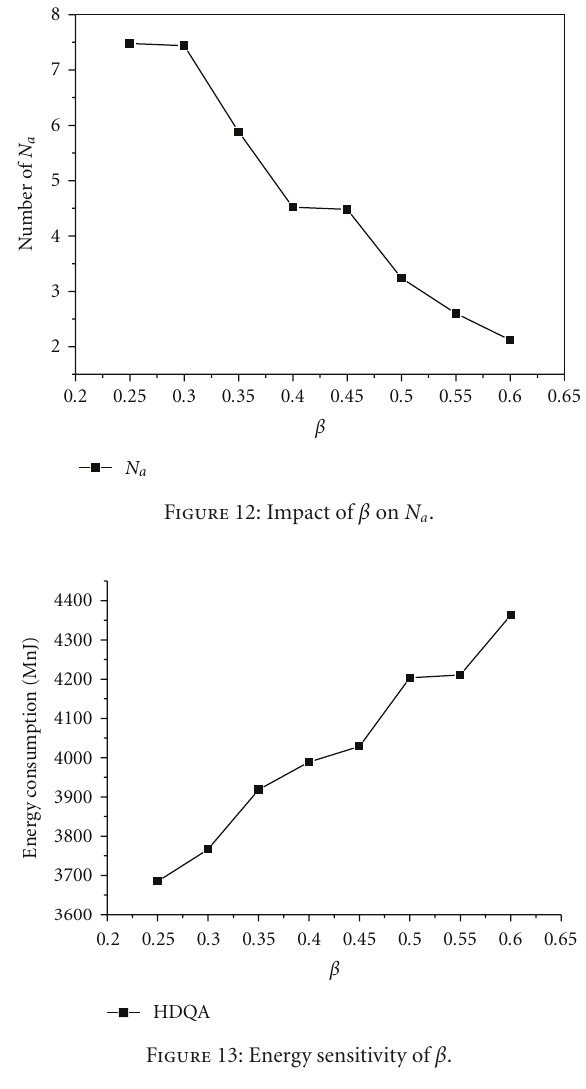
Figure 13: Energy sensitivity of β